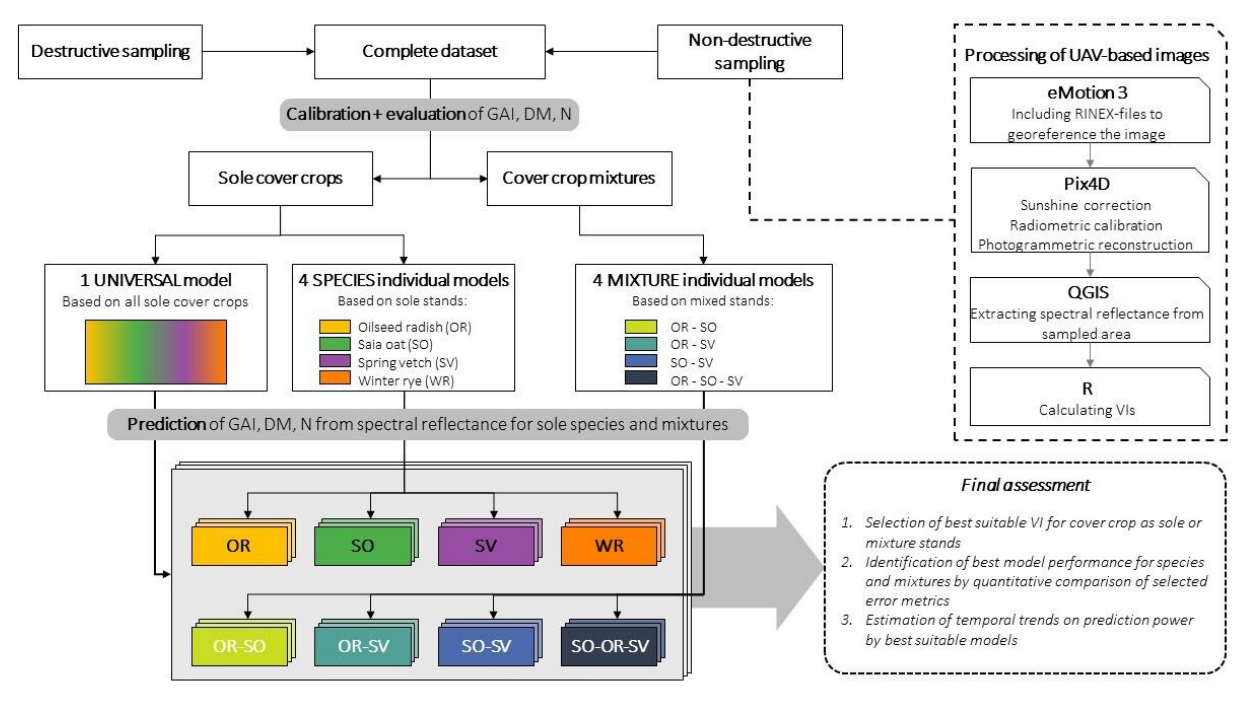
Figure 1. Workflow of the drone-based, non-destructive sampling, model calibrations (universal, species – and mixture – individual model), and the prediction possibilities of the green area index (GAI), dry matter (DM), and N uptake (N) of the respected species or mixture.